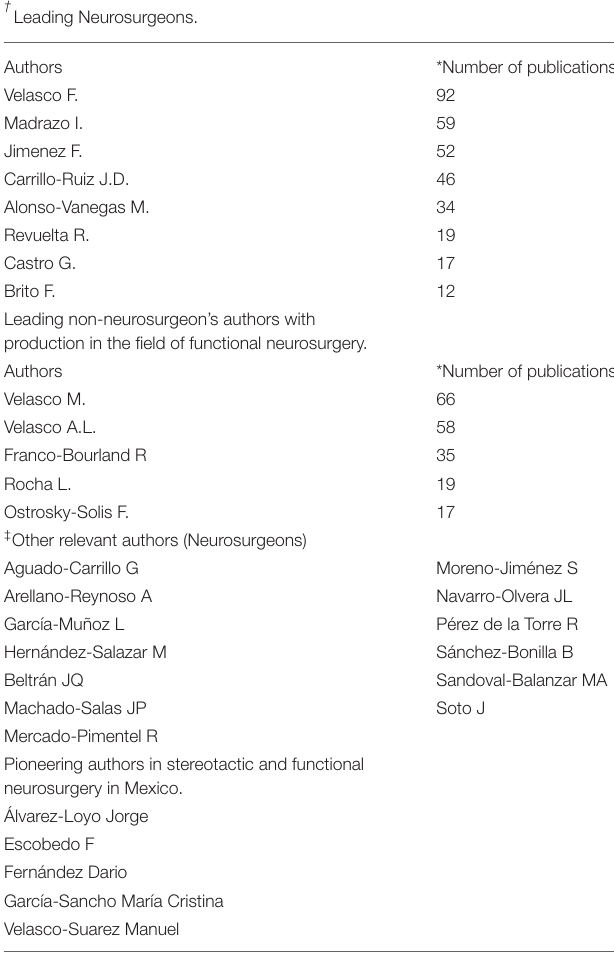
TABLE 3 | Leading authors in stereotactic and functional neurosurgery (SFN) in Mexico. † Leading